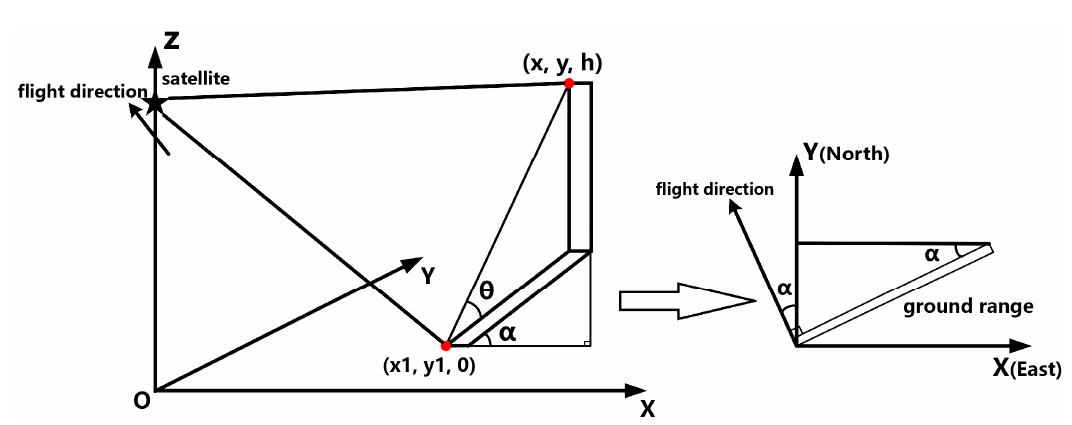
Figure 2. Schematic diagram of ortho-rectification.